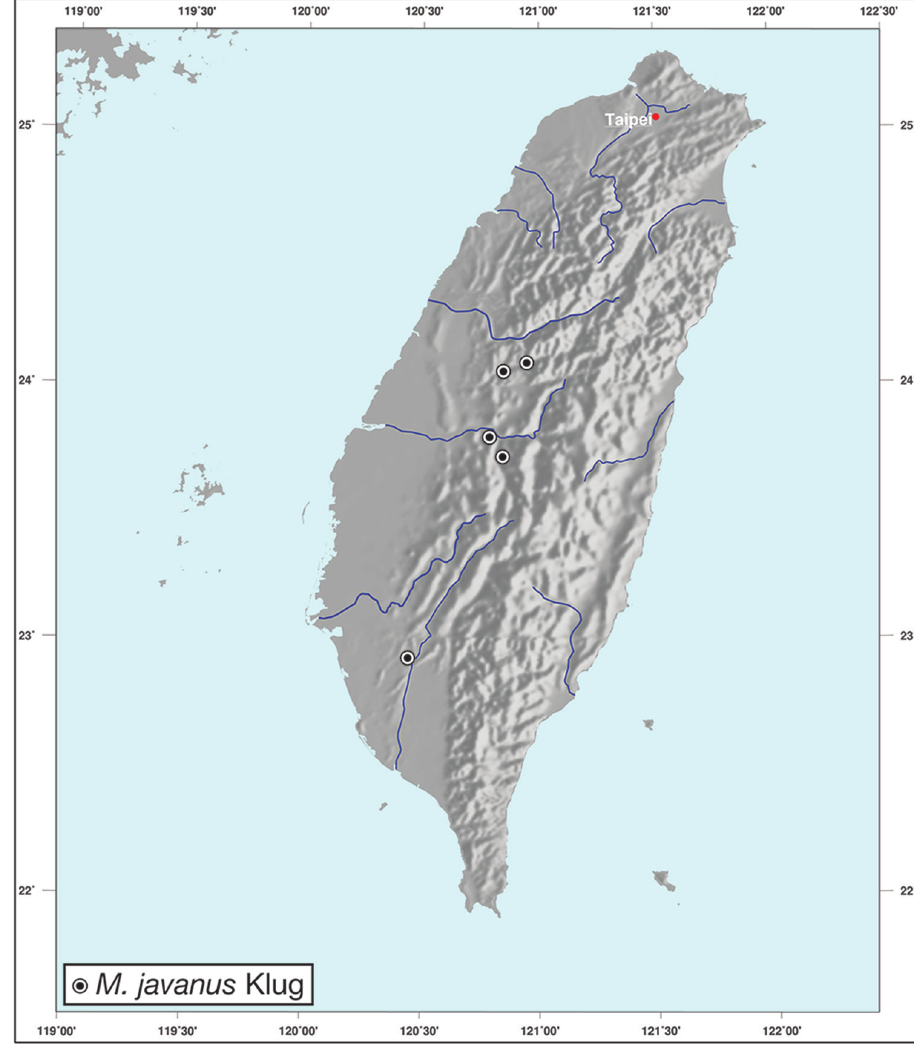
Figure 93. Map showing known localities for species of the genus Miscelus Klug, in